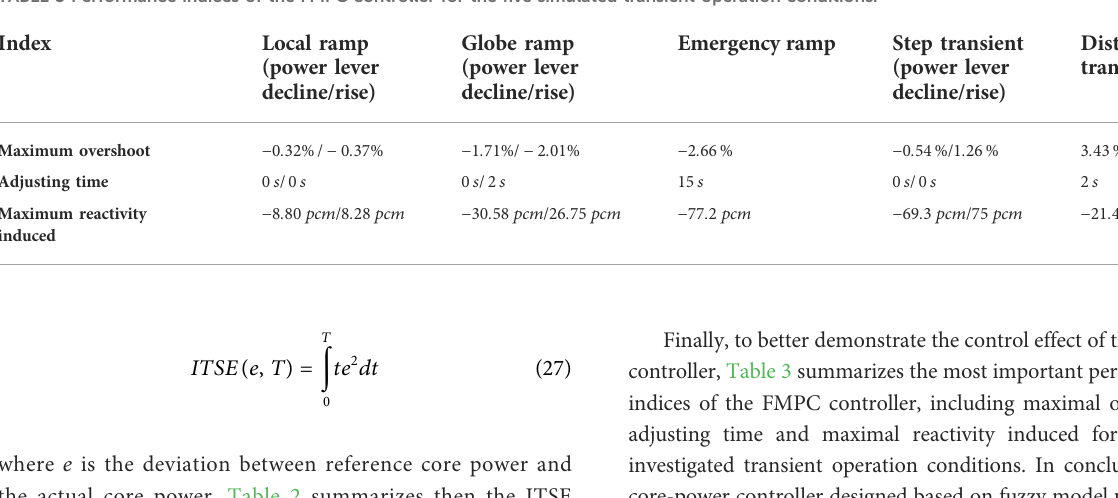
TABLE 3 Performance indices of the FMPC controller for the fi ve simulated transient operation conditions.